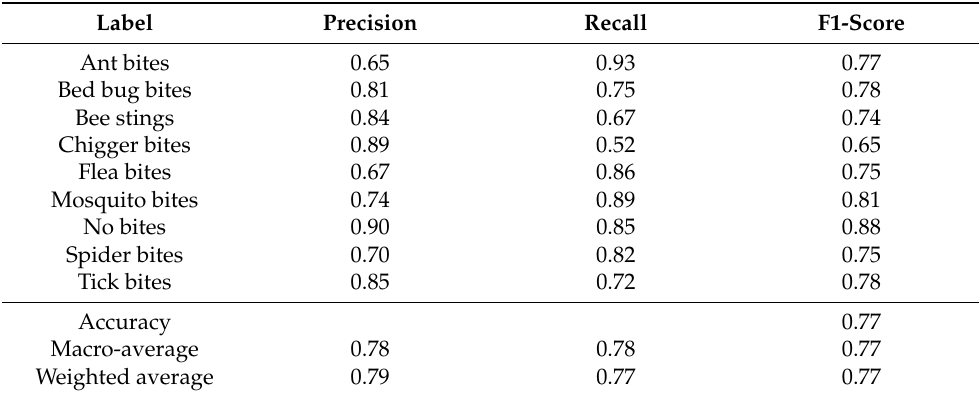
Table 12. Evaluation metrics for Inception-v3 model.